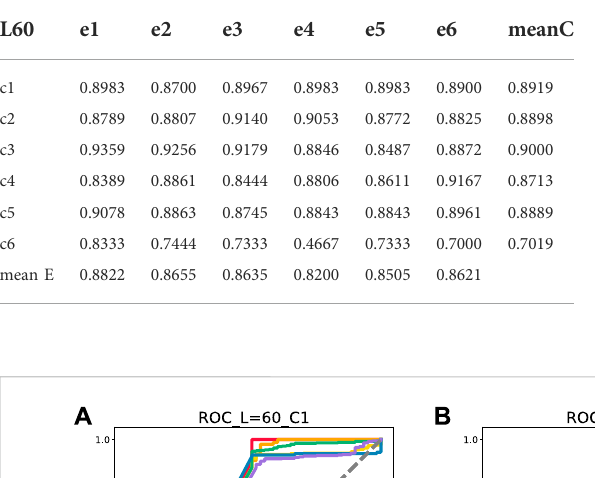
TABLE 6 The mean results of each multilayer network of the six crises in the 60-day window.